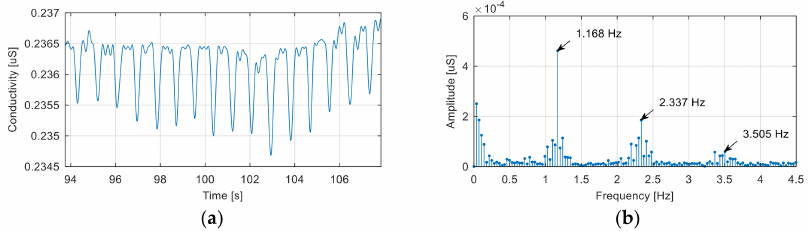
Figure 5. Example of a signal a ff ected by electrical network noise ( a ) signal in the time domain; ( b ) frequency spectrum of the signal.